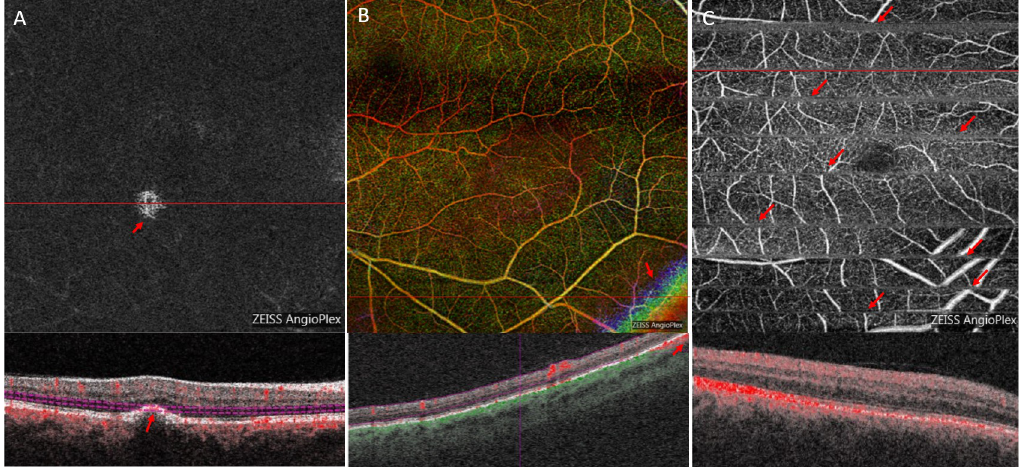
Fig 1. Examples of artifacts. For each artifact OCTA enface and B-Scans are shown. Red arrows indicate the artifacts, red lines indicate the corresponding B-scan. (A) segmentation artifact retina avascular layer. (B) out of window artifact retina layer depth encoded. (C) motion artifact retina